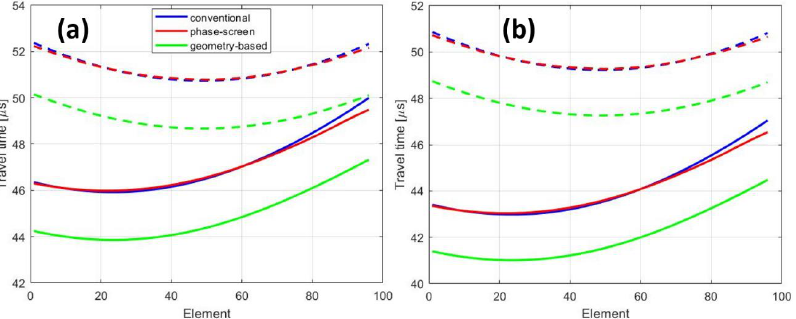
Figure 9 . The travel-time estimated for scatterer 1 (solid lines) and scatterer 3 (dashed lines) posi- tioned in patch 1 and 3, respectively (see Figure 3c), with the three different reconstruction techniques when a steered plane wave at ( a ) − 15 degree and ( b ) 0 degree is used for transmission. The bone and background models were flat and homogeneous, respectively. As indicated by the numerical results in Figure 6, accurate estimation of the AP with the beamsum channel correlation method when the brain tissue has a heterogeneous wave-speed is very challenging if the amplitude of the beacon signal is not high enough. The image quality obtained by the PS method in this scenario is poor (panel c in Figures 5 and 6).